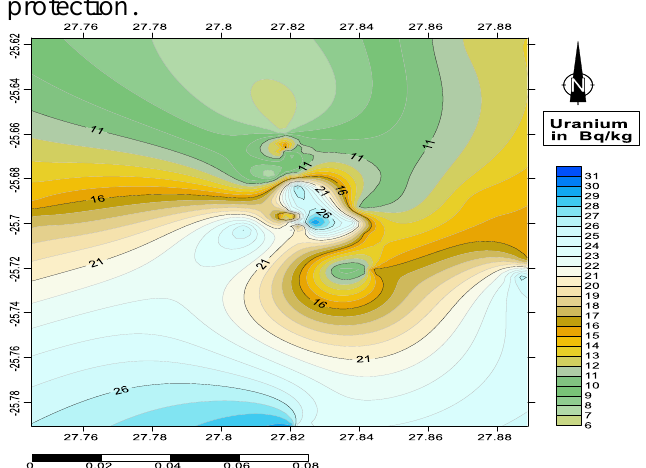
Figure 1: Spatial distribution of 238 U in the study area